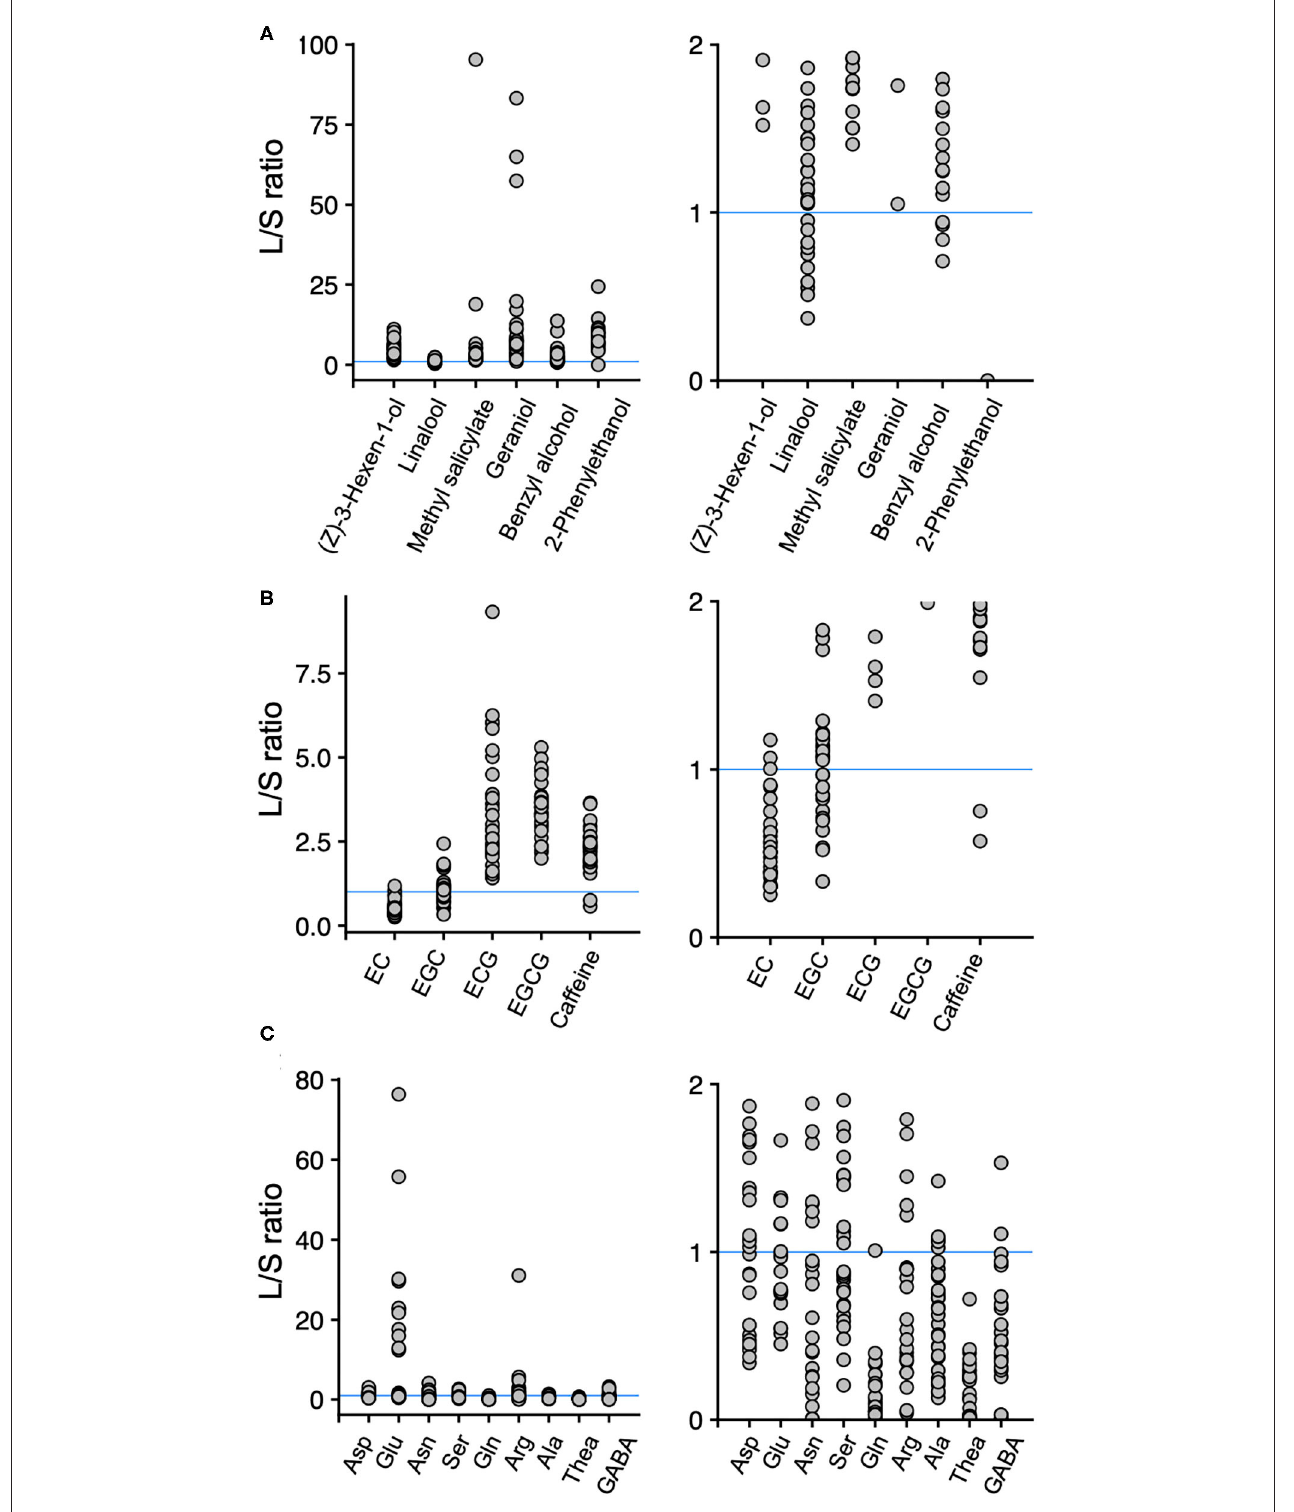
FIGURE 3 | Ratios of the contents of main volatiles (A) , main catechins and caffeine (B) , and main amino acids (C) in new leaves to those in new stems. Each plot represents accessions. Each figure on the right is a close-up of the figures on the left. A leaf/stem (L/S) ratio > 1 indicates that new leaves have a higher content of the component than the new stems, and L/S < 1 indicates that new stems have a higher content of the component than the new leaves in an accession. Blue lines indicate L/S = 1.